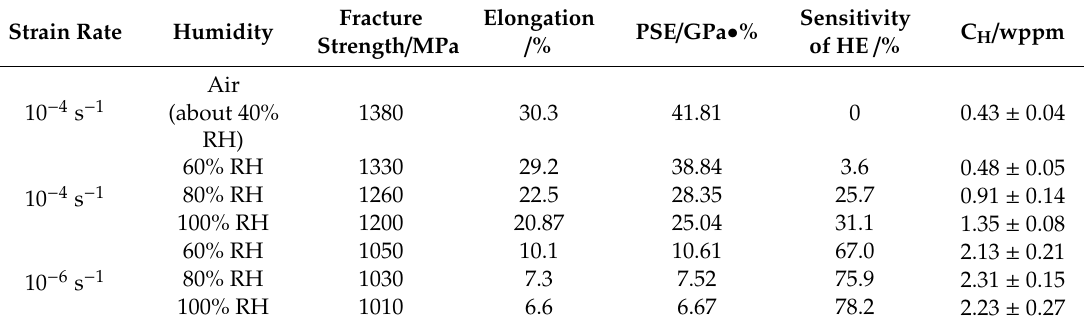
Figure 9. Nominal stress–strain curves under humidity for M10B. Table 3. Mechanical properties and sensitivity of hydrogen embrittlement after SSRTT for M10B.